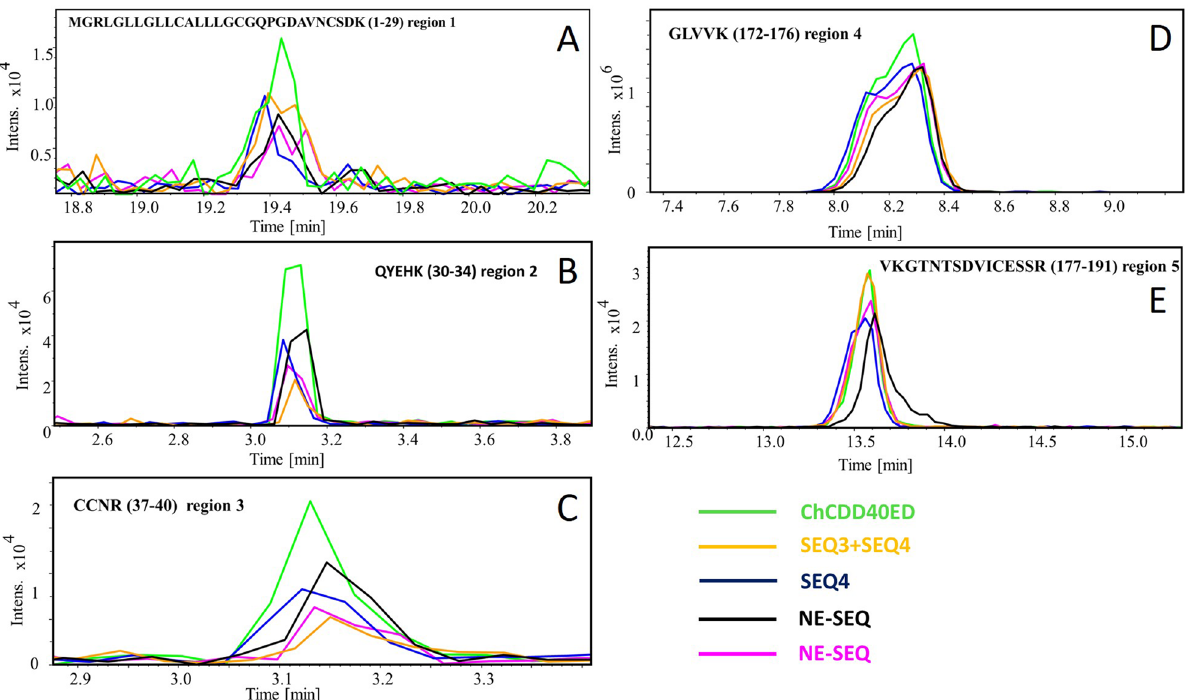
Figure 3. LC–ESI–MS results. After the incubation of the chCD40ED protein (25,712 Dalton) with the aptamers sequences (SEQ3, SEQ4, SEQ3 + SEQ4 or NC-SEQ), the protein was subjected to the action of trypsin digestion for overnight. Three distinct regions (Regions 1, Region 2 and 3 in ( A ), ( B ) and ( C ), respectively; see also Fig. 4B) on the protein sequence were protected from the digestion with trypsin enzymes ( A , B and C ), mostly by SEQ3 + SEQ4. The data collected at different time point (s) were plotted to show the intensity of the peaks. Other regions in Figure ( C ), ( D ) where little protection is provided by aptamers are also shown as a negative